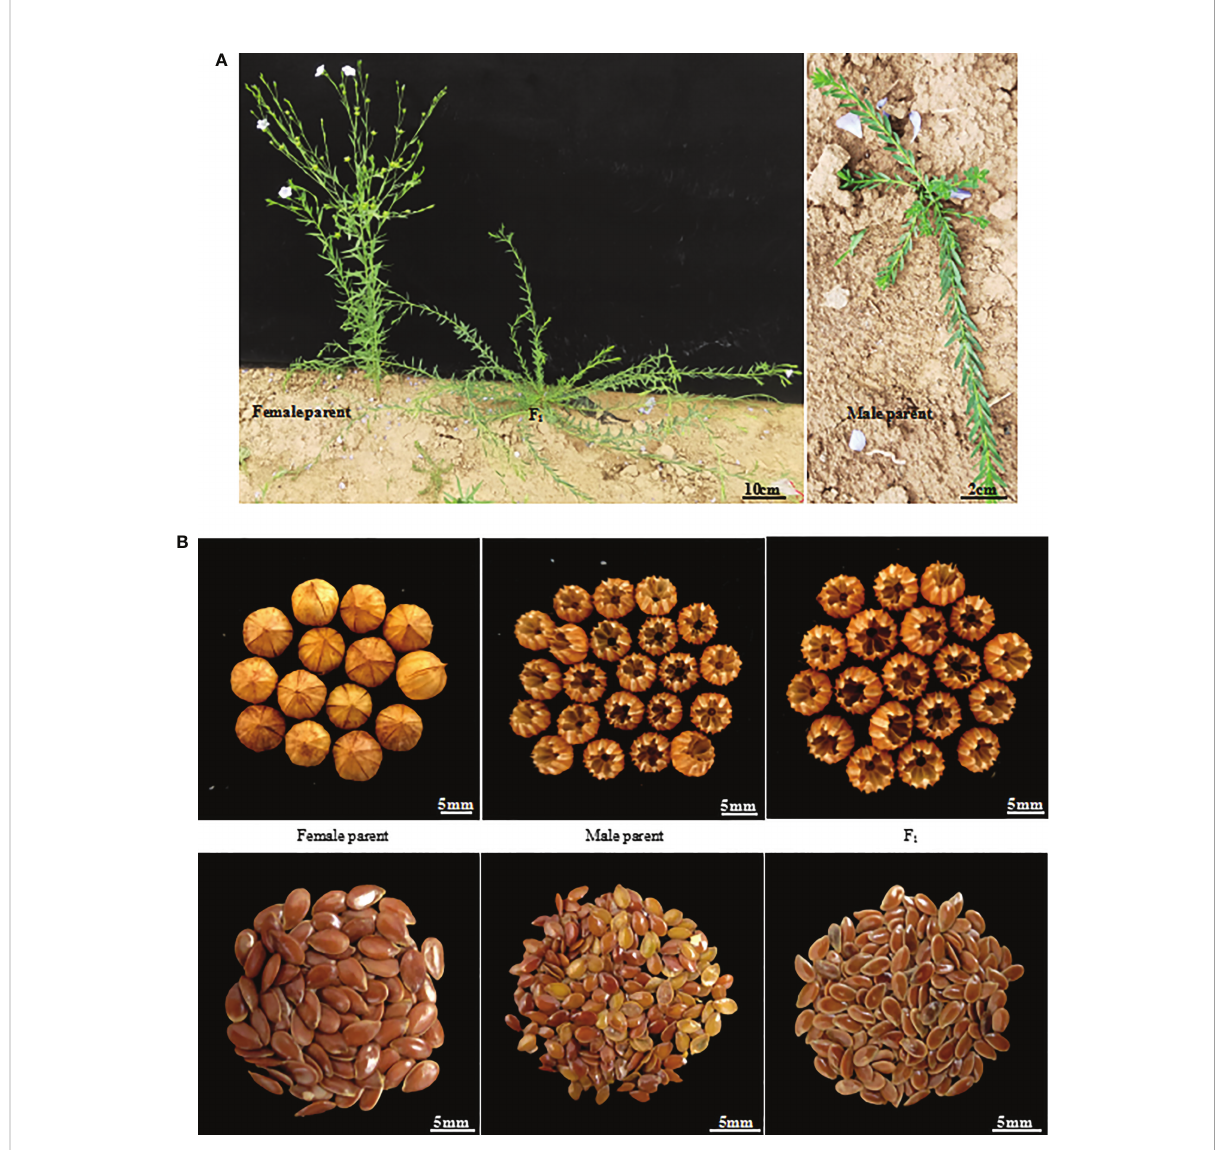
FIGURE 1 Morphological traits of parents and their generation line F 1 of Longya-10×pale fl ax hybridization combination. (A) Growth habit; (B) Capsules and